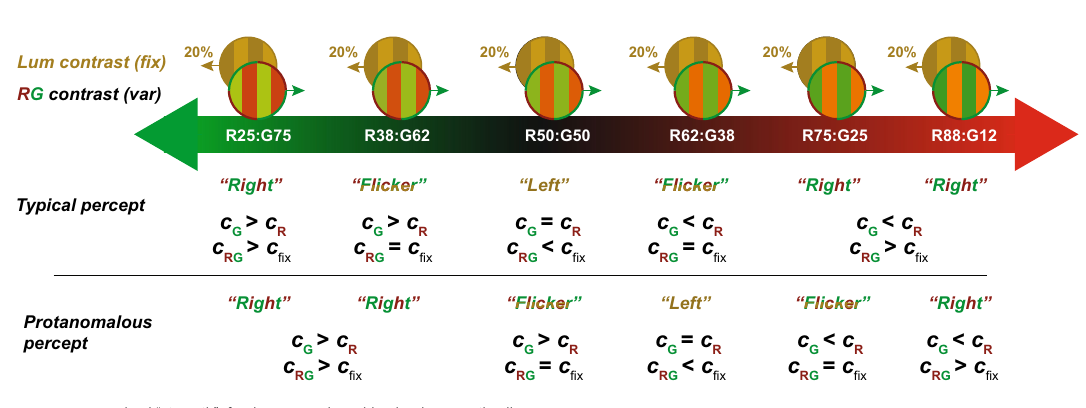
Figure 2. Expected results from the anomaloscope for different CVd groups. The x-axis shows the ratio of red-green in the reference ranging from 0 (pure green) to 73 (pure red). The y-axis indicates the luminance of the yellow test scaled from 0 (black) to 40 (maximum brightness)—that matched the corresponding red- green test. Lines are labelled with the corresponding CV category. Because the red and green primaries of the anomaloscope lie along the red-green axis, the test captures the colours readily confused by dichromats. As a result, extreme dichromats can match the yellow test to red-green references spread across the entire colour mixture range—solid arrows. CVn observers on the other hand see contrast between colours and will match only at near-equal ratios of red and green (40–50). Mild dichromats—dashed lines being less sensitive to either red or green, require a greater amount of that colour to make a luminance match, thus matching values on either side of the CVn range.